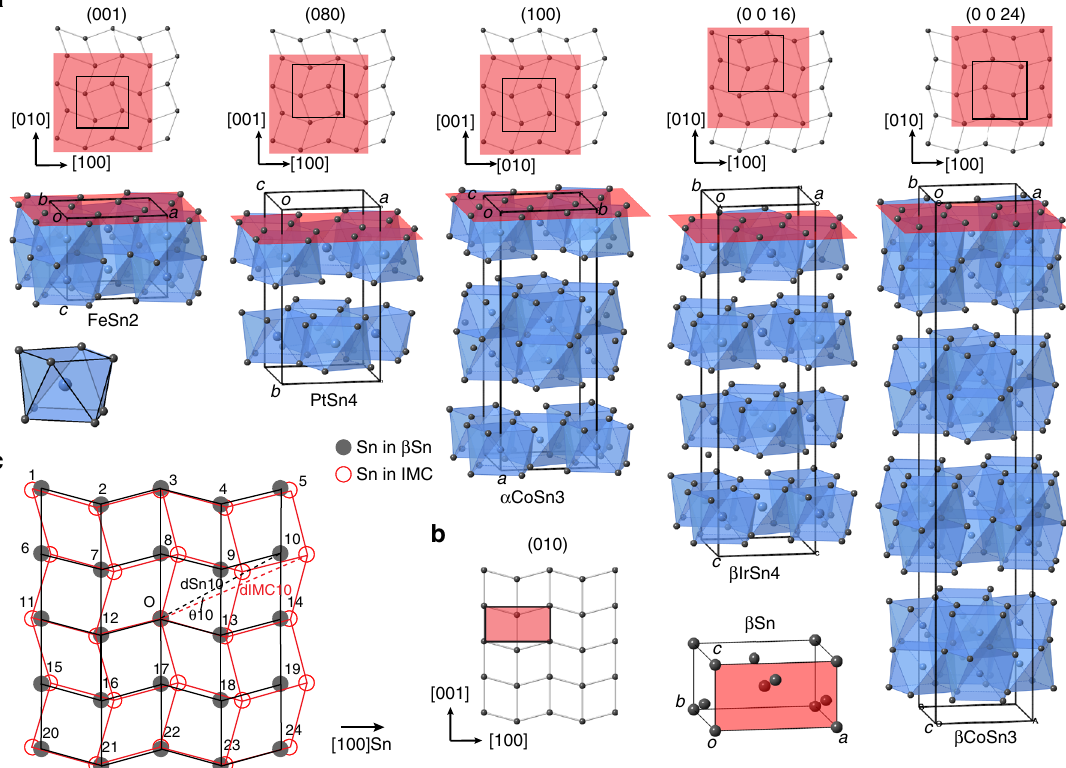
Fig. 2 Lattice match between β Sn and a family of transition metal stannides. a Each crystal structure is shown in an equivalent orientation as a stacking of distorted-square antiprisms. A single distorted antiprism with Sn atoms on the vertices and a T atom at the center is shown underneath FeSn 2 . Red planes represent the similar net of Sn atoms in each structure. The black square on each net of Sn atoms indicates the projection of the corresponding unit cell, and its position is determined by the origin for the crystallographic settings in Table 1. b β Sn unit cell and (100) plane. c Planar lattice match between the (100) of β Sn and the red planes containing Sn nets in the IMCs, showing the atomic mis fi t of 24 atoms surrounding the origin labeled ‘ O ’ (unrelaxed structures). Here α CoSn 3 is used as the